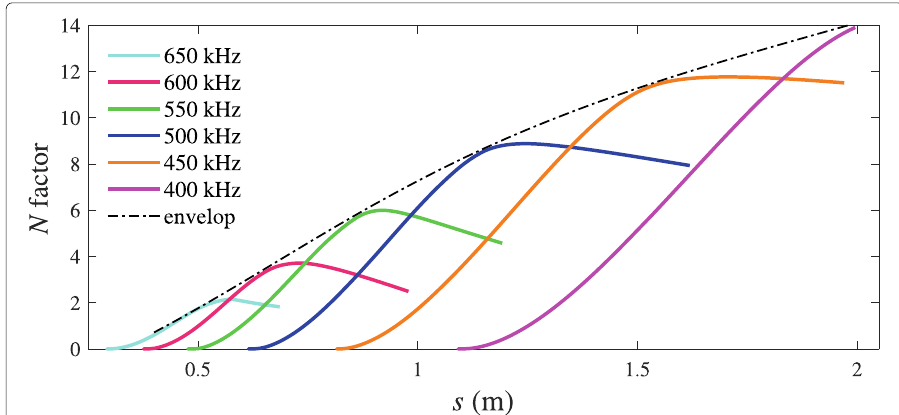
with f = 400 kHz, the maximum N factor is over 14. The transition onset location can be determined from the e N method after a correlation to experimental results.